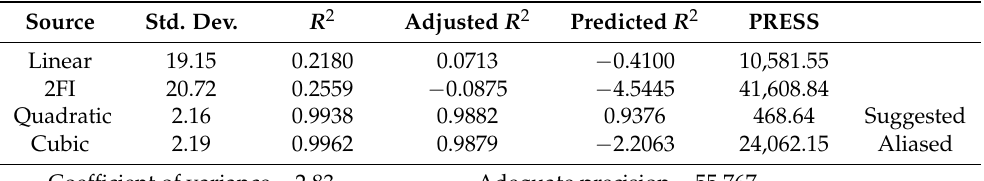
Table 5. Model Summary Statistics.